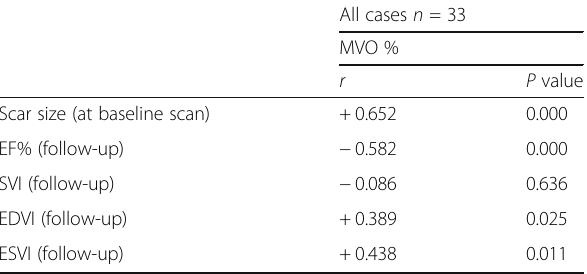
Table 3 Correlation between MVO size % and baseline scar size together with LV volumes measured at 2nd visit (follow-up) and